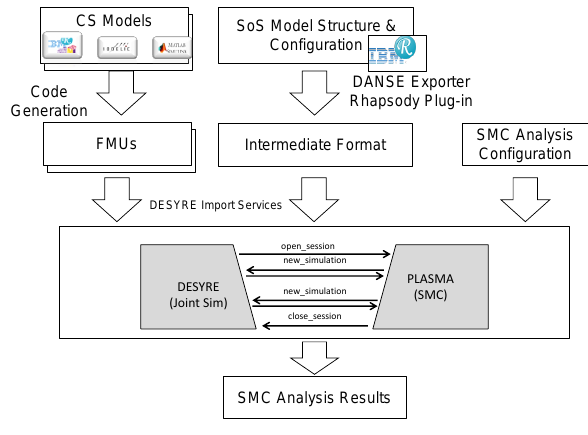
Figure 4. SMC Analysis